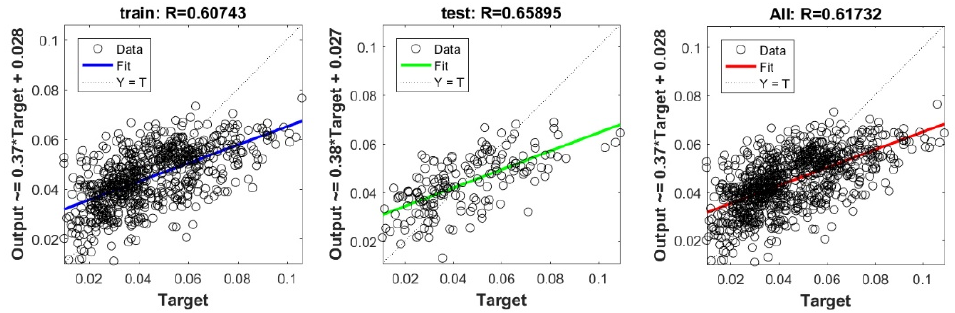
Figure A17. Scatter plots between target and output value by the GT-RF model.